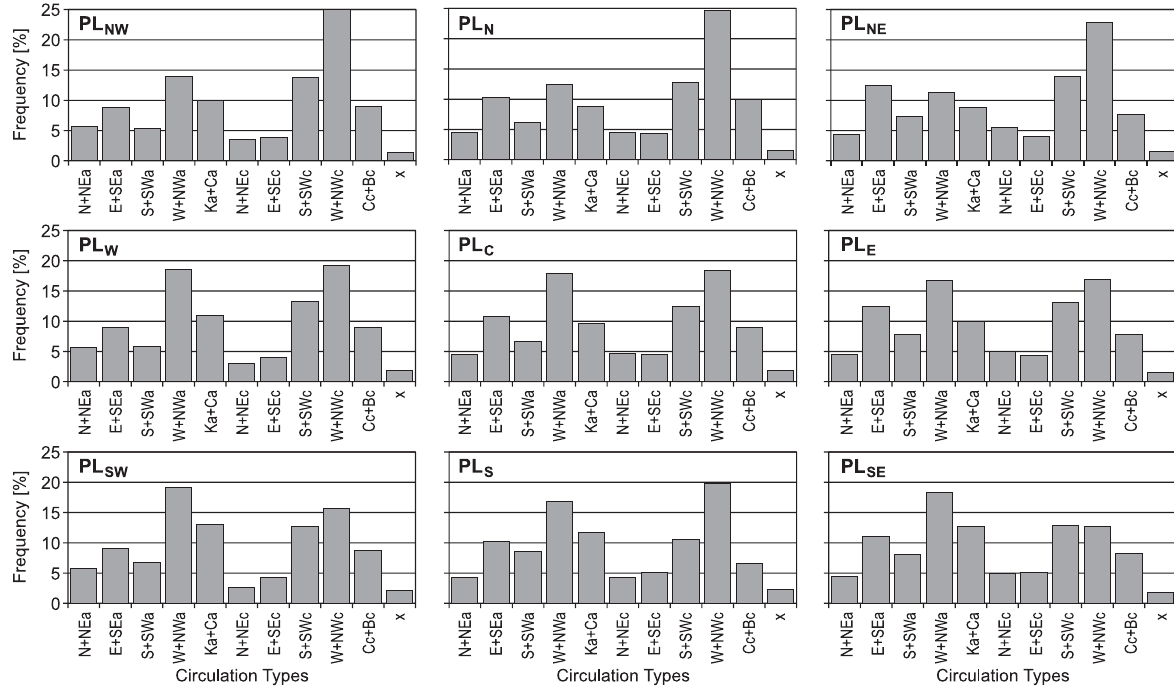
Fig. 2. Frequency of circulation types in winter (DJF) for grid box within Poland. PL